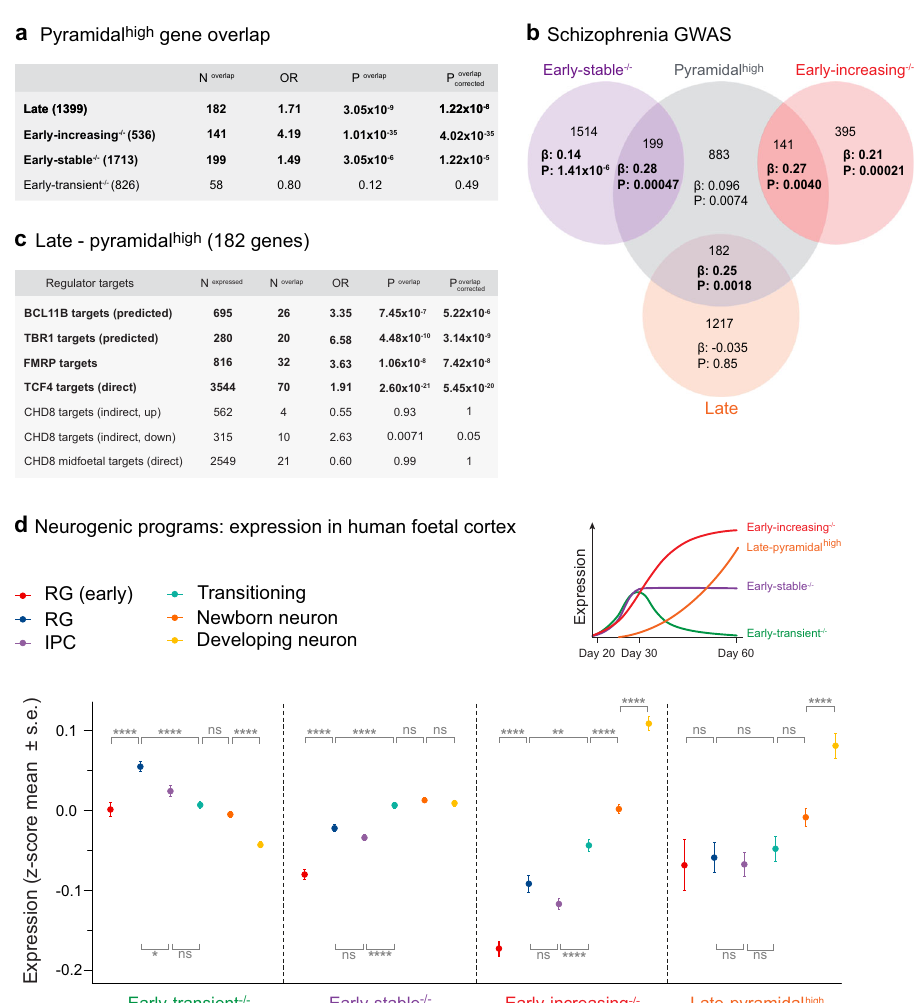
Fig. 7 Expression of early neurogenic programs in neurodevelopmental cell-types from human fetal cortex. a Identi fi cation of programs enriched/ depleted for genes with high expression in CA1 pyramidal neurons relative to other brain cell-types (pyramidal high ); enrichment compared to all expressed genes (two-sided Fisher ’ s Exact Test). Raw and Bonferroni-corrected p values given ( P overlap , P overlap corrected ), correction is for the 4 tests performed. b Pyramidal high genes were partitioned based on their overlap with neurogenic programs. Each segment of the Venn diagram shows the number of genes in each subset and the regression coef fi cient ( β ) and uncorrected p value ( P ) for SZ common variant enrichment (one-sided MAGMA test), conditioning on all expressed genes. Bold indicates enrichments surviving correction for 7 tests. c A one-sided Fisher ’ s Exact Test was used to identify key regulators whose known/predicted targets are over-represented amongst pyramidal high genes overlapping the late neurogenic program when compared to all expressed genes; both raw and Bonferroni-corrected p values are given ( P overlap , P overlap corrected ), where correction is for the 7 regulator sets tested. d Cells corresponding to distinct neurodevelopmental cell-types (RG radial glia; IPC Intermediate progenitor cell), including cell-types at different stages of maturity, were identi fi ed and extracted from a previously published single-cell RNA-seq study of human fetal cortex across peak stages of neurogenesis 32 (Methods). >80% of genes belonging to each in vitro-de fi ned early neurogenic program and 55% of the late-pyramidal high set (top RHS) were present in the fetal data (early-transient − / − n = 665 genes; early-stable − / − n = 1484 genes; early-increasing − / − n = 431 genes; late-pyramidal high n = 101 genes). For each program, the mean and standard error of gene-level expression averages (see main text/Methods) were calculated for each fetal cell-type/ developmental stage. The fetal data captures both direct (RG ➝ neuron) and indirect (RG ➝ IPC ➝ neuron) neurogenic pathways. The (deep layer) neurons present in our day 30 – 60 cultures in vitro are predominantly born via the direct neurogenic pathway. For each program, differences between gene- level averages for successive cell-types/stages were evaluated using a two-tailed Student ’ s t test and p values Bonferroni-corrected for 6 pairwise comparisons. * p < 0.05; ** p < 0.01; **** p < 0.0001. All data presented as mean ± SEM. Bold indicates tests surviving Bonferroni correction. The exact p values are provided in Supplementary Data